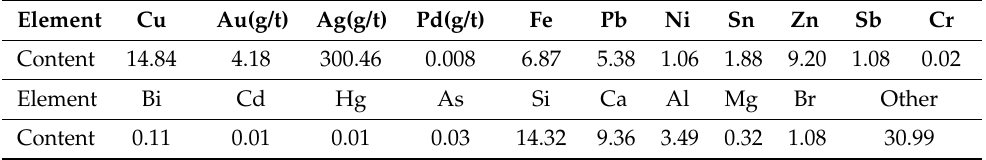
Table 3. Chemical composition of the waste heat boiler (WHB) dust, wt.%.